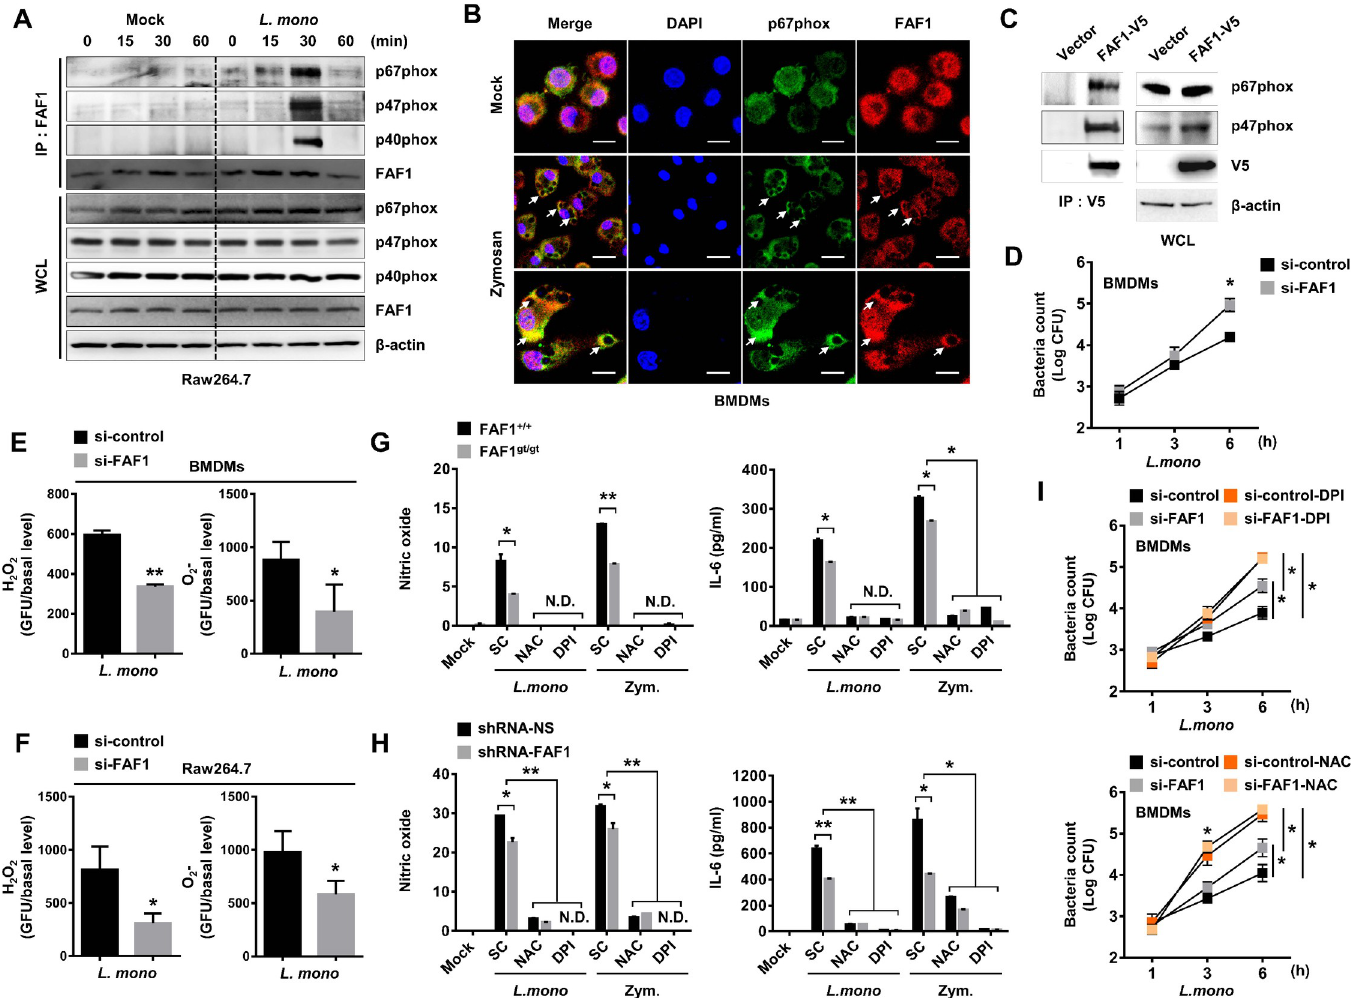
Fig 3. FAF1 interacts with p67phox, leading to inflammatory responses following L . monocytogenes infection. (A) Mock- or L . monocytogenes- infected Raw264.7 cells were harvested at indicated times and cell lysates were used for immunoprecipitation (IP) with an anti-FAF1 antibody, followed by immunoblotting with anti-p67phox, p47phox, p40phox, and FAF1 antibodies. (B) BMDMs were treated with mock or zymosan (100 μ g/ml) for 30min, followed by confocal microscopy with an anti-p67phox antibody and an anti-FAF1 antibody. Scale bars represent 10 μ m. (C) Raw264.7 cells containing empty vector or V5-tagged FAF1 were used for IP with an anti-V5 antibody, followed by immunoblotting with anti-p67phox, p47phox antibodies. (D) At 36hr post-transfection with siRNA-control or siRNA-FAF1, BMDMs were infected with L . monocytogenes (MOI = 0.1) for 1hr. Bacteria-containing medium was replaced with fresh medium containing gentamycin. Then, cells were washed with PBS and lysed by Triton X-100 at the indicated time, followed by CFU titration for counting intracellular bacteria. (E-F) At 36hr post-transfection with siRNA-control or siRNA-FAF1, BMDMs (E) or Raw264.7 cells (F) were infected with L . monocytogenes , then used for measuring H 2 O 2 or O 2- production. (G) FAF1 +/+ and FAF1 gt/gt BMDMs were infected with L . monocytogenes (MOI = 1) for 2hrs or stimulated with zymosan w/ or w/o NAC or DPI (20 μ M). At 18hr, the supernatants were analyzed for NO production or IL-6 secretion. (H) Control Raw264.7 cells (shRNA-NS) and FAF1 knockdown Raw264.7 cells (shRNA-FAF1) were infected with L . monocytogenes (MOI = 1) for 2hrs or stimulated with zymosan w/ or w/o NAC or DPI (20 μ M). At 18hr, the supernatants were analyzed for NO production or IL-6 secretion. (I) At 36hr post-transfection with siRNA-control or siRNA-FAF1, BMDMs were infected with L . monocytogenes (MOI = 0.1) for 1hr. Bacteria-containing medium was replaced with fresh medium containing gentamycin w/ or w/o DPI or NAC. Then, cells were washed with PBS and lysed by Triton X-100 at the indicated time, followed by CFU titration for counting intracellular bacteria. Data are representative of two (A, C, D, G, H, I) or three (B, E, F) independent experiments. Error bars, mean ± SD. � P < 0.05, �� P < 0.01 (Student‘s t -test), compared to FAF1 +/+ or control (si-control or shRNA-NS). N.S., no significant; N.D., no